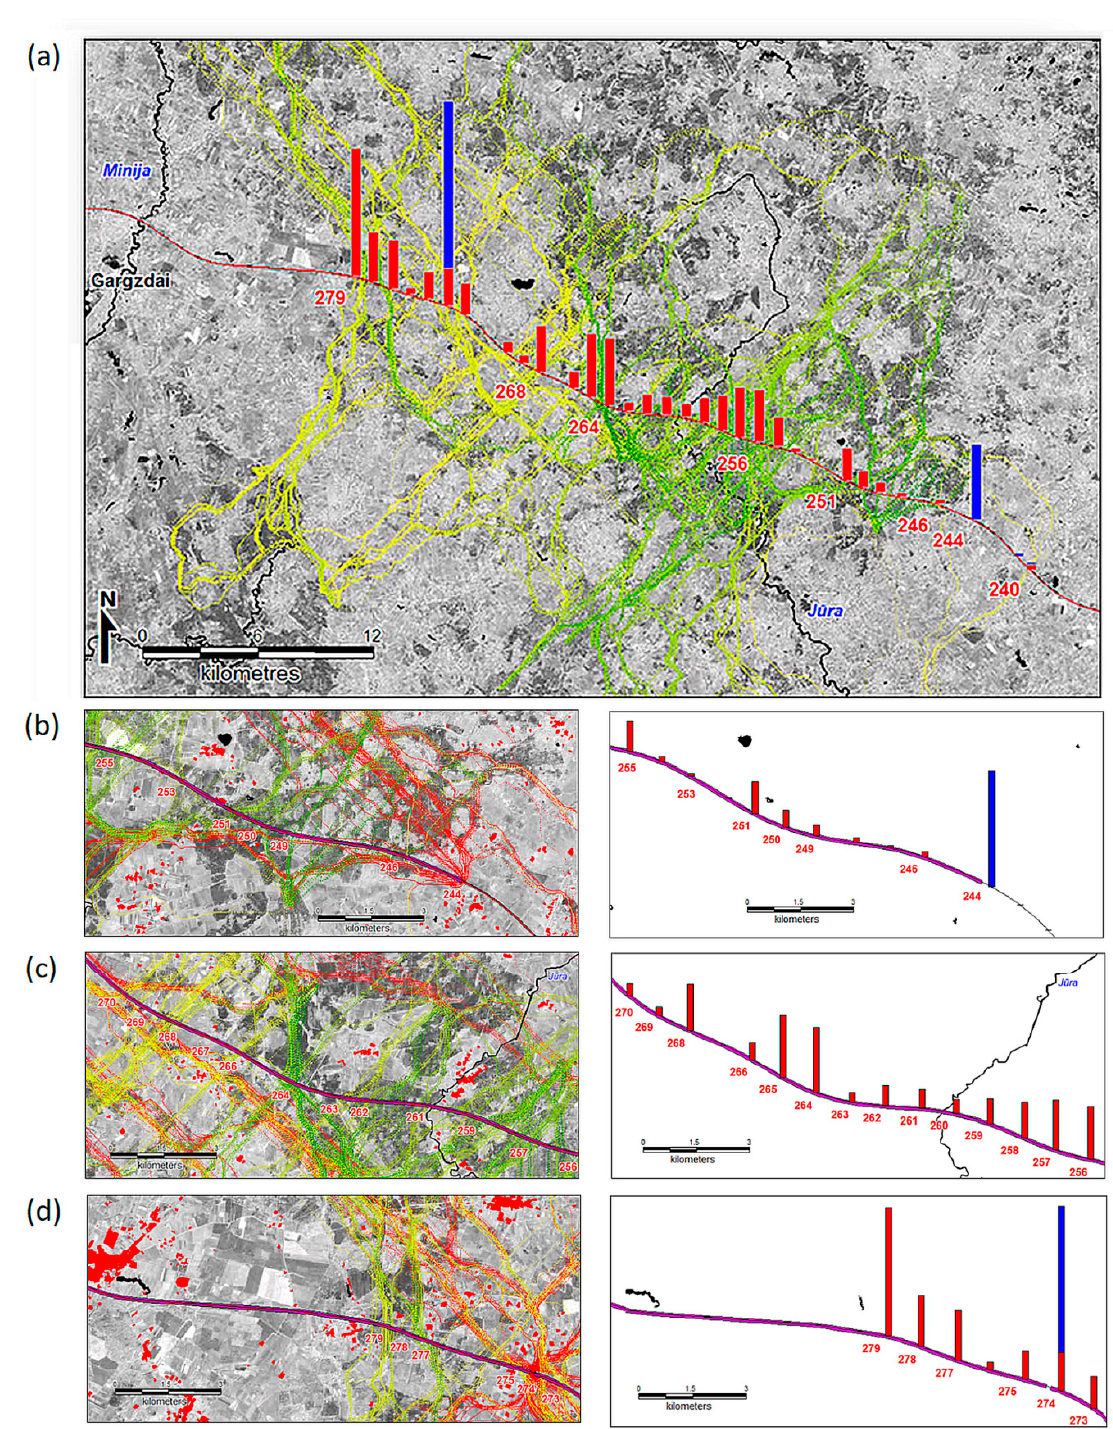
Figure 4. Simulated movements of the three ungulate species across highways A1 and A2 in Lithuania as of 2007: number of crossings of red deer ( a ) and wild boar ( c ) per linear km of the highway, and number of crossings and density (km per square km of the habitat) of pathways of roe deer ( b ).